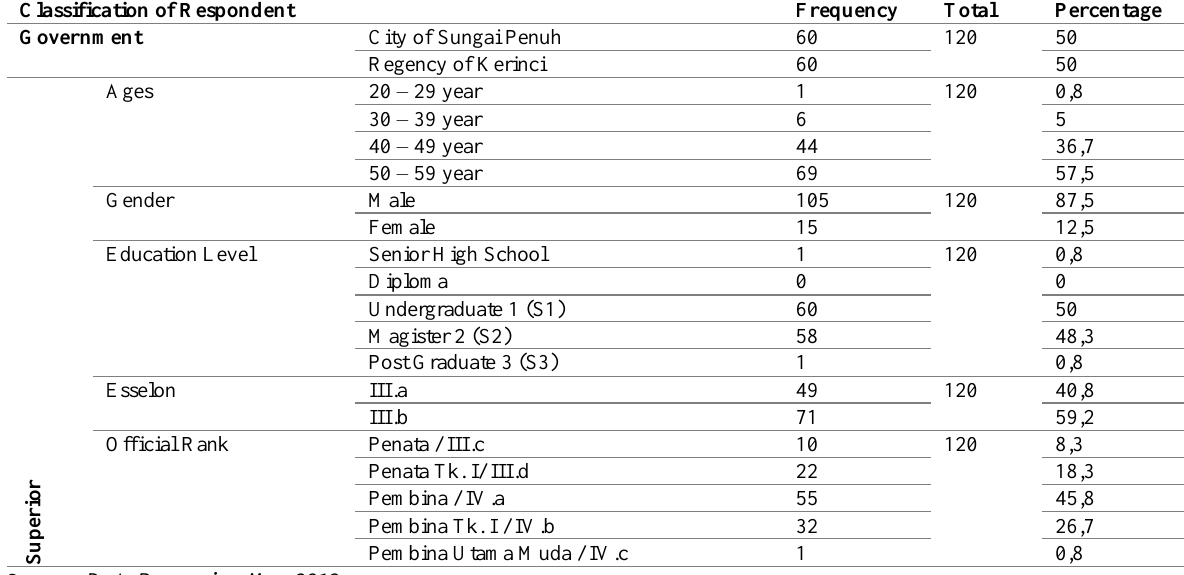
Table 1 : Profile of respondent of superior in administrator